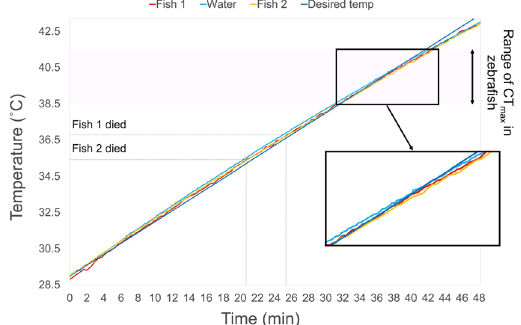
Figure 6. Body temperature of deep dorsal muscle of two zebrafish (Fish 1, weight = 0.4 g, length = 28 mm: red line; Fish 2, weight = 0.4 g, length = 26 mm: yellow line) plotted against ambient water temperature (light blue line) shows a lag in temperatures of less than 0.2 °C. The desired thermal ramping rate of 0.3 °C min − 1 (dark blue line) is also plotted to show that the ambient water temperature closely follows the desired water